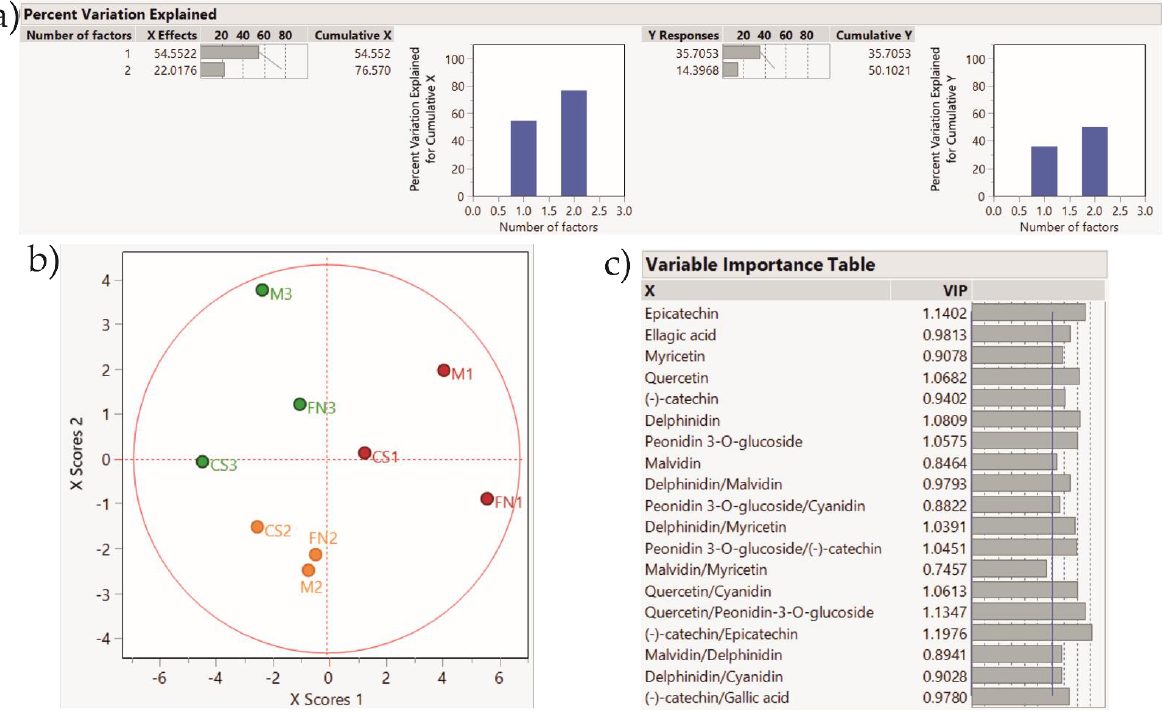
Figure 7. PLS-DA score plot showing sample clustering for Stage 2 wines. Color coding: red—Murfatlar 2014; orange— Murfatlar 2015; green—Valea Călugărească 2015. ( a ) Percent of variation explained by the two factors; ( b ) PLS-DA score plot; ( c ) VIPs (Variable Importance for the Projection) showing the predictors and their importance in determining the PLS projection model.